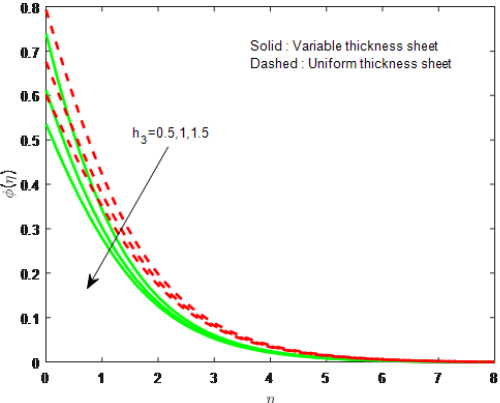
Fig. 17: Influence of h 2 on temperature field